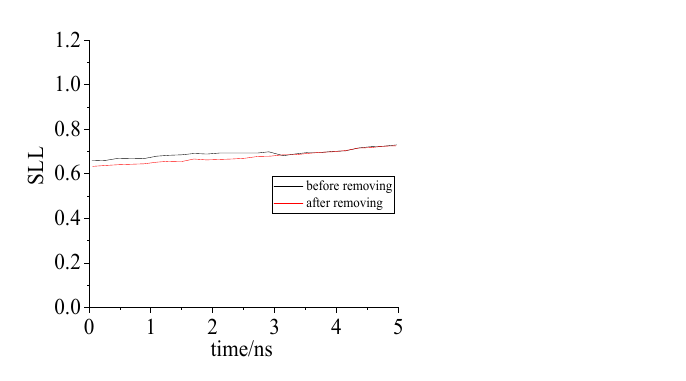
Figure 12. Comparison of before and after removing the unimportant elements.